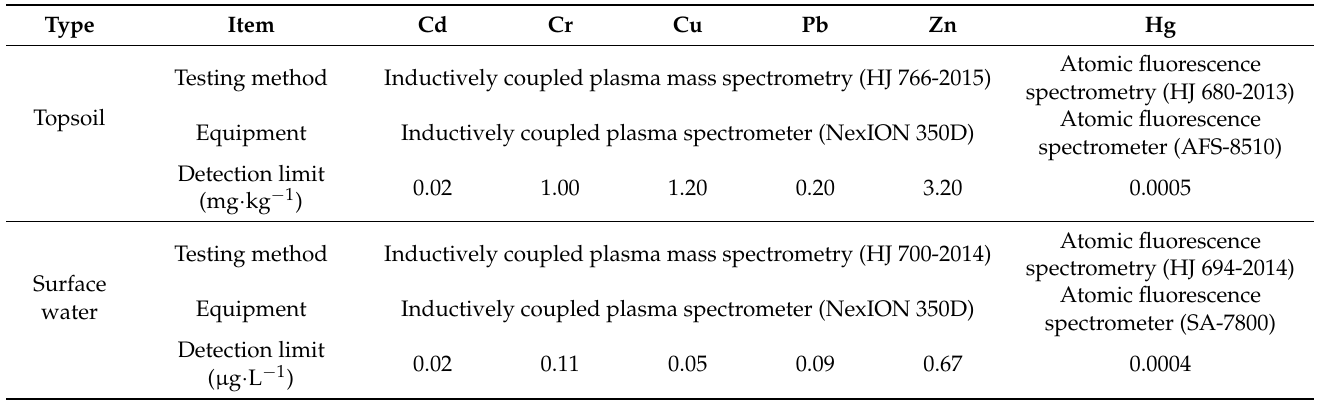
Table 1. Testing methods for heavy metal